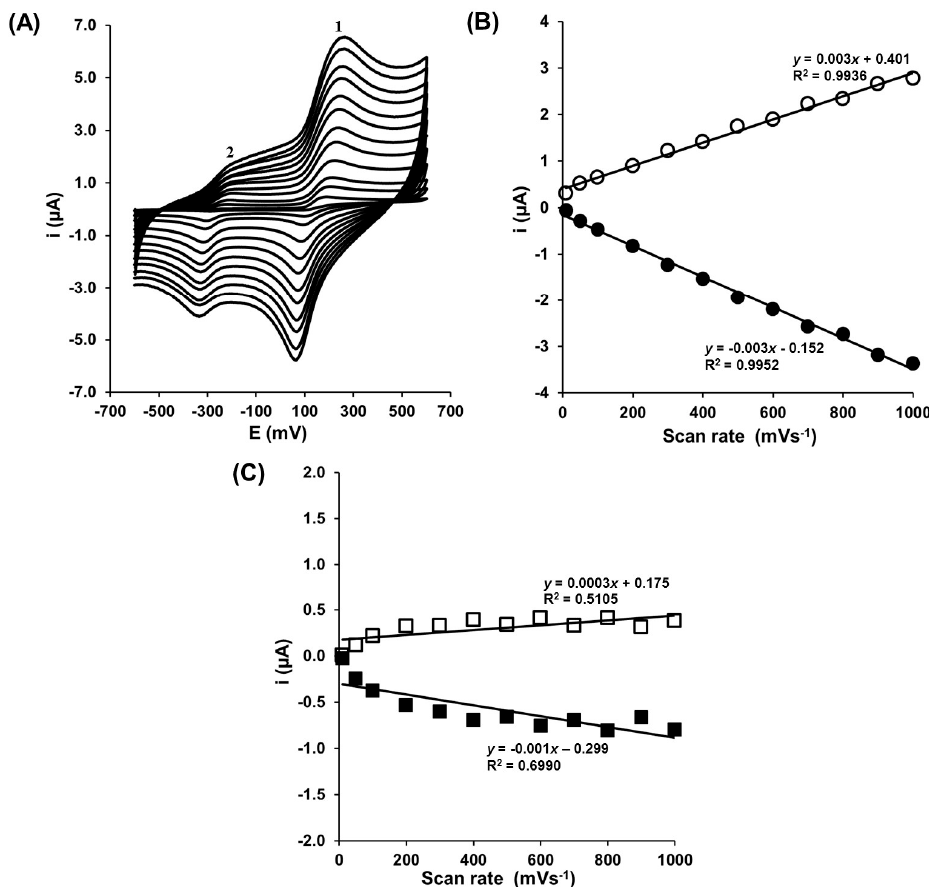
Figure 2. ( A ) Representative cyclic voltammograms recorded for gold electrode modified with HSCX-COOH/MET in the presence of 0.1 mM DA. Scan rate: 10–1000 mV s − 1 ; ( B ) Plots of ( ○ ) anodic and ( ● ) cathodic current of 0.1 mM DA vs. scan rate for peak 1; ( C ) Plots of ( (cid:3) ) anodic and ( (cid:4) ) cathodic current of 0.1 mM DA vs. scan rate for peak 2. All measurements were done in phosphate-buffered saline (PBS) pH